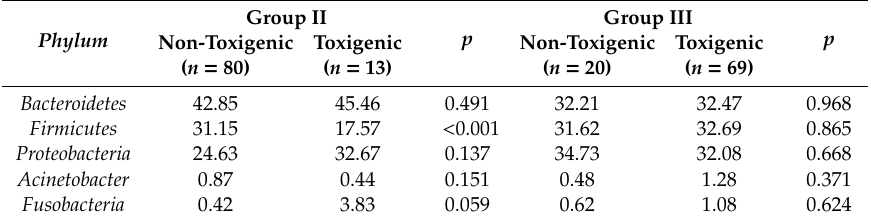
Table 3. Comparison of the mean relative abundance (%) of the composition of phyla between non-toxigenic and toxigenic C. di ffi cile in group II and group III.